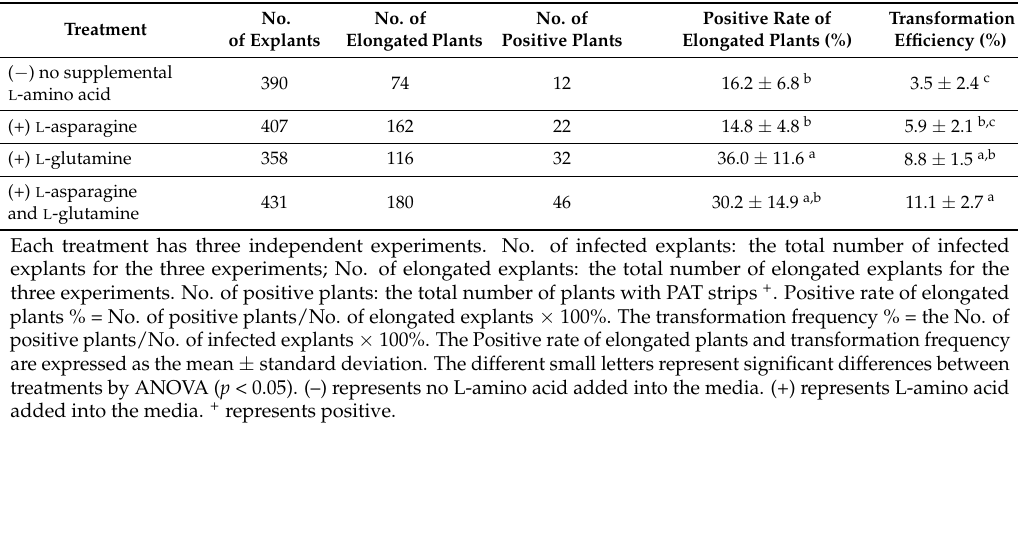
Figure 2. Detection of transgenic plants. ( a ) Negative plants by leaf painting; ( b ) Positive plants by leaf painting; ( c ) Strips detection: 1 Negative plant, 2–4 Positive plants, the bands at black arrowhead indicate that bar is positive; ( d ) Negative plants by GUS staining;( e , f ) Positive plants by GUS staining. Scale bar, 1 cm. Table 4. Detection of elongated plants and transformation frequency for the different